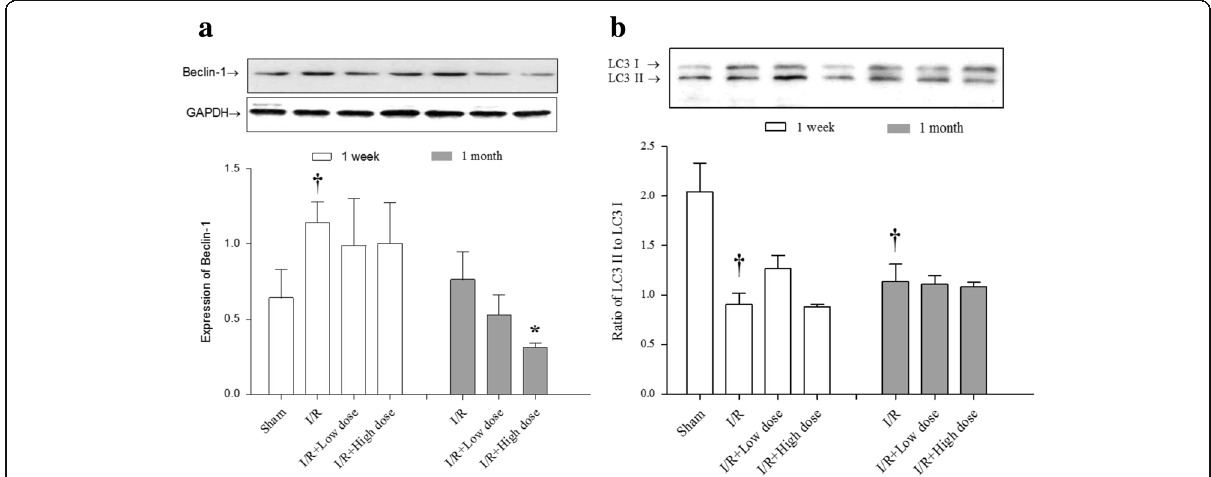
Fig. 4 Effects of MYQ on the expression of Beclin-1 and LC3. a Expression of Beclin-1, upper is the representative blots of Beclin-1 and GAPDH; lower is the densitometric analysis of Beclin-1 expression normalized to GAPDH ( n = 8). b Expression of LC3, upper is the representative blots of LC3 I and LC3 II; lower is the densitometric analysis of the ratio of LC3 II to LC3 I ( n = 8). Sham: Sham group; I/R: ischemic/reperfusion group. I/R + Low dose: Low dose (1 ml, P.O. tid for one-week or 1 month) MYQ treatment group. I/R + High dose: High dose (4 ml, P.O. tid for one-week or 1 month) MYQ treatment group. All data were expression as mean ± S.E.M. † P < 0.05 compared with sham